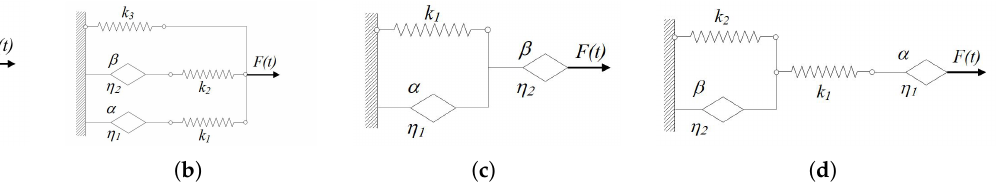
Figure 8. FOGF models. ( a ) FOZGF model. ( b ) FOMGF model. ( c ) FOTGF model. ( d ) FOBGF